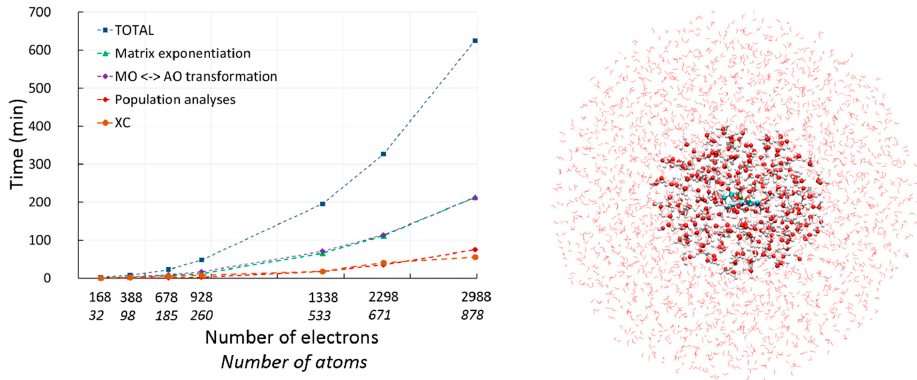
Figure 4. Computational performances for QM / MM RT-TD-ADFT simulation. Left: scalability of code with size QM region. Right: Simulated system with QM and MM atoms represented with balls-and-sticks and lines respectively. The picture represents the QM / MM calculation with the largest QM systems (878 atoms).